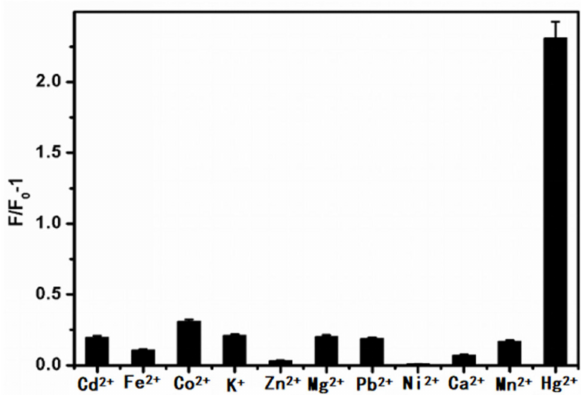
Figure 4. Detection of different metals ion using GO-dsDNA sensor. Table 2. Results for the determination of Hg 2+ in the tap water ( n = 10). Samples